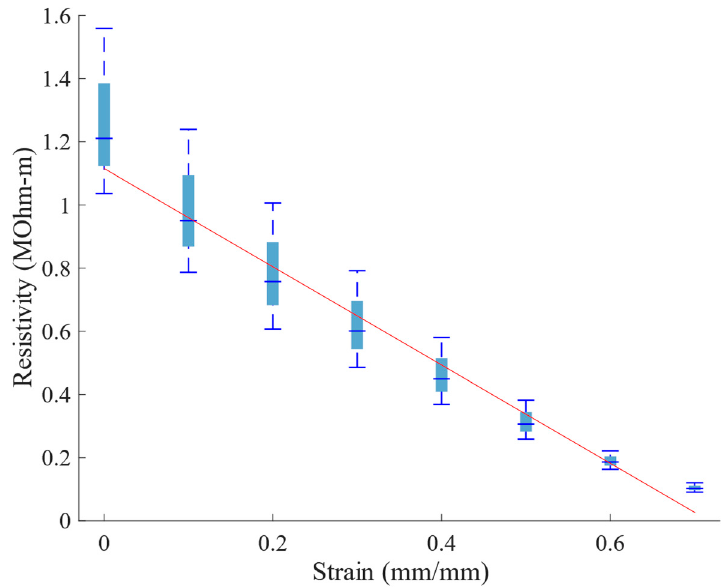
Figure 12. Resistivity versus strain; resistance was measured across a 1 mm in-plane gap between copper